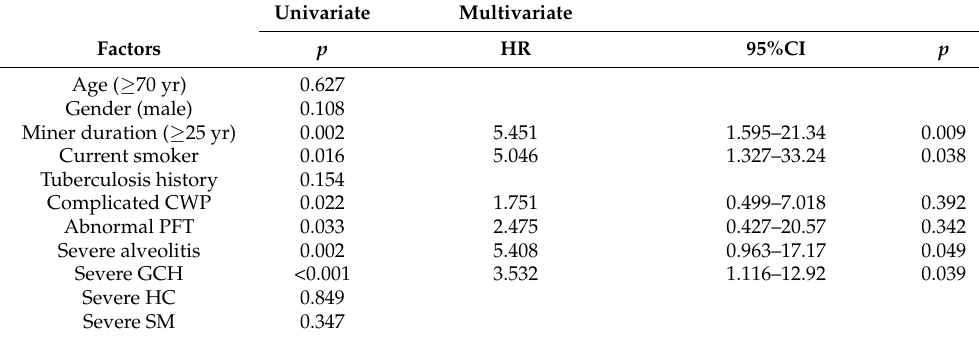
Table 5. Survival analysis of pulmonary morbidity of cancer-free coal workers’ pneumoconiosis. Univariate Multivariate